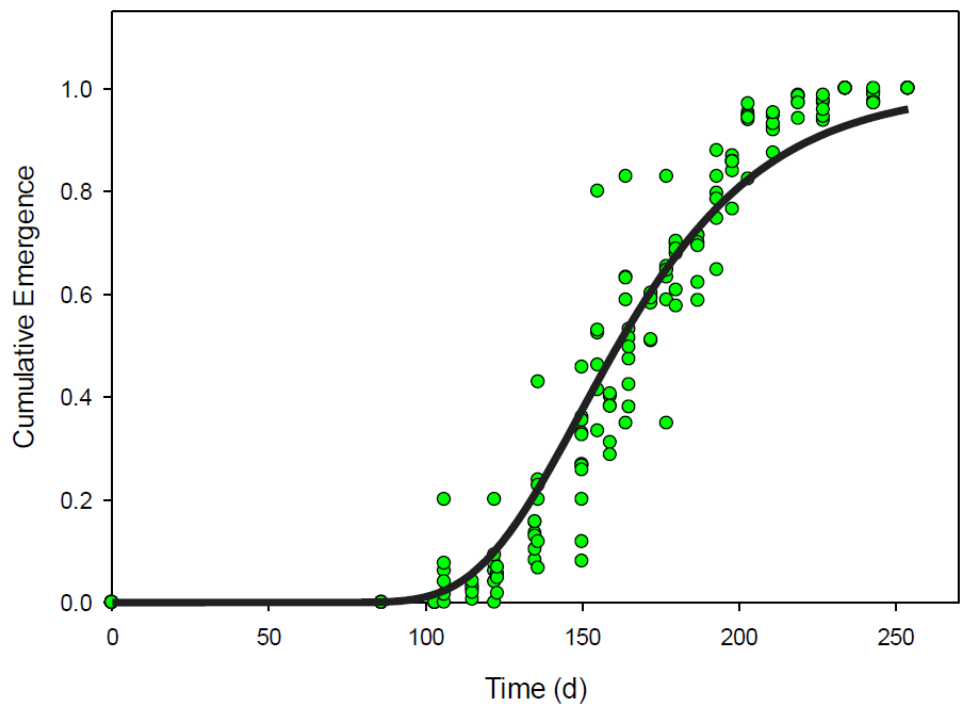
Figure 3. Expected Senna obtusifolia over time as predicted by the Gompertz model fit to relative cumulative pixels (solid line). Observed relative cumulative emergence from true counts of Senna obtusifolia over time (green circles).